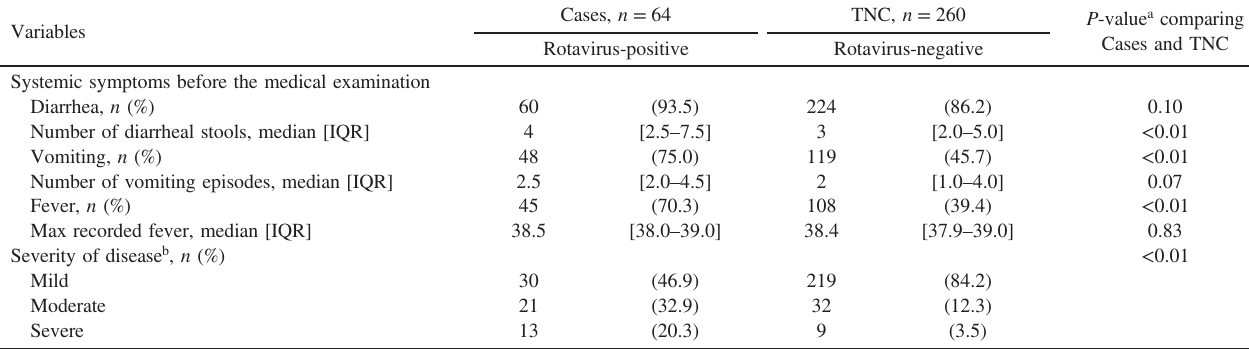
Cases, n = 64 TNC, n = 260 P -value a comparing